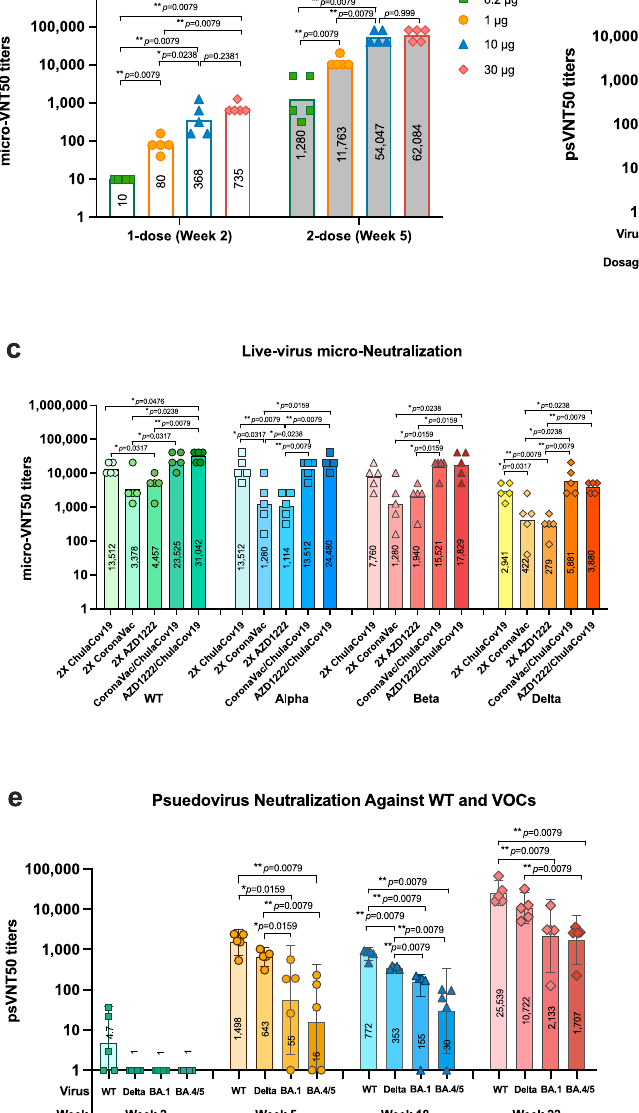
Experiment 3: e psVNT50 NAb against WT (Wuhan-Hu1), Delta (B.1.617.2), and Omicron (BA.1 and BA.4/5) variants for NAb durability and effect of 3 rd dose of ChulaCov19 studies. The titers were determined in duplicate assays from 5 mice in eachgroup.Note;4mice in 10 µ ggroup wereanalyzed forpsVNT50againstBA.4/5 due to the limited volume of serum samples. Each dot represents an individual animal.Barsrepresent the GMTsand 95%CI for eachgroup.Statisticalsigni fi cance was determined by two-sided Mann – Whitney tests. Differences were considered by * and **, respectively. Source data are provided as a Source Data fi